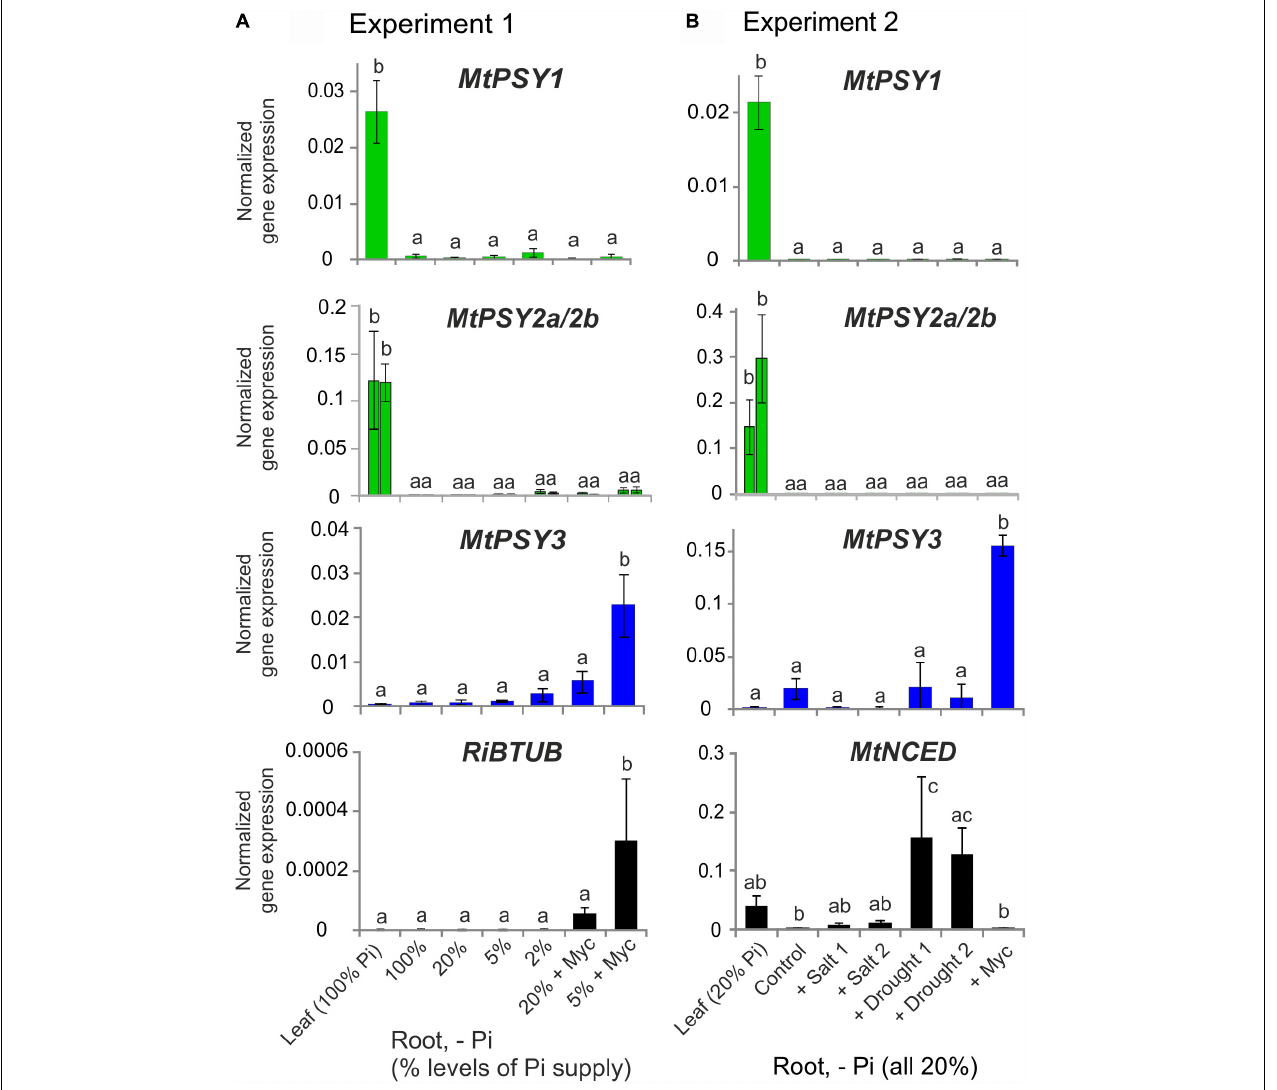
FIGURE 2 | Normalized transcript levels of PSY isogenes from M. truncatula under phosphate-starvation, mycorrhization, salt and drought stress conditions in leaves and roots. Plants from two independent experiments (A,B) were harvested after 5 weeks of cultivation in expanded clay under the various phosphate starvation (– Pi), mycorrhization (+ Myc) salt treatment (+ salt) or drought (+ drought) conditions as indicated. qRT-PCR data were normalized to constitutively expressed MtEF1 α . Error bars indicate SD from at least three biological replicates. An AM fungal marker gene ( R. irregularis β -TUBULIN , RiBTUB ) or a marker gene of ABA biosynthesis ( MtNCED ) were included in the analysis of experiment 1 or 2, respectively (lower panels). Please note adapted scales in the various panels. Error bars derive from SD of at least three biological replicates. Different lower case letters indicate statistically different values in ANOVA followed by a Tukey HSD test ( p ≤